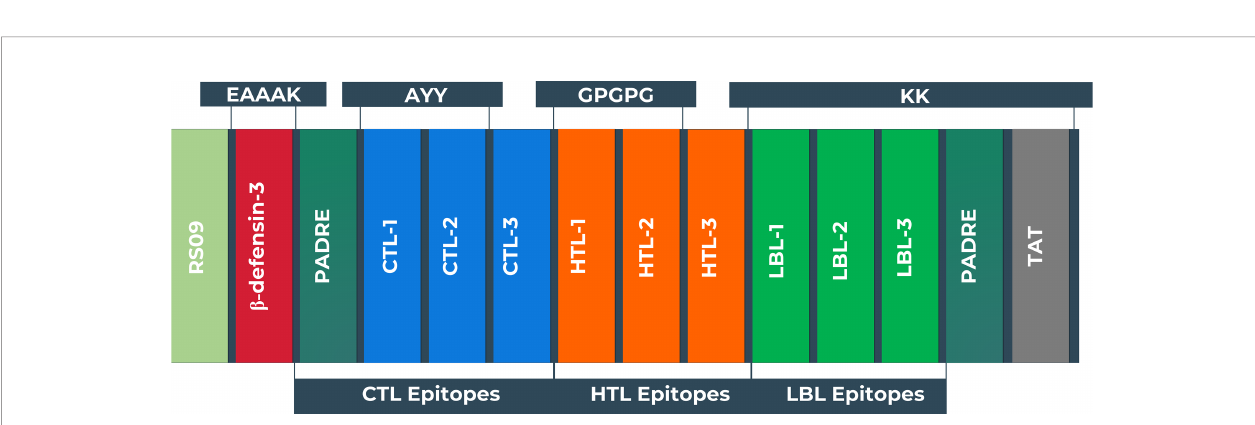
FIGURE 4 | Schematic representation of the vaccine constructs with its linkers (EAAAK, AAY, GPGPG, KK), adjuvant (RS09 and human beta-defensin-3), PADRE, and TAT sequence, and epitopes (CTL, HTL, LBL) in a sequential